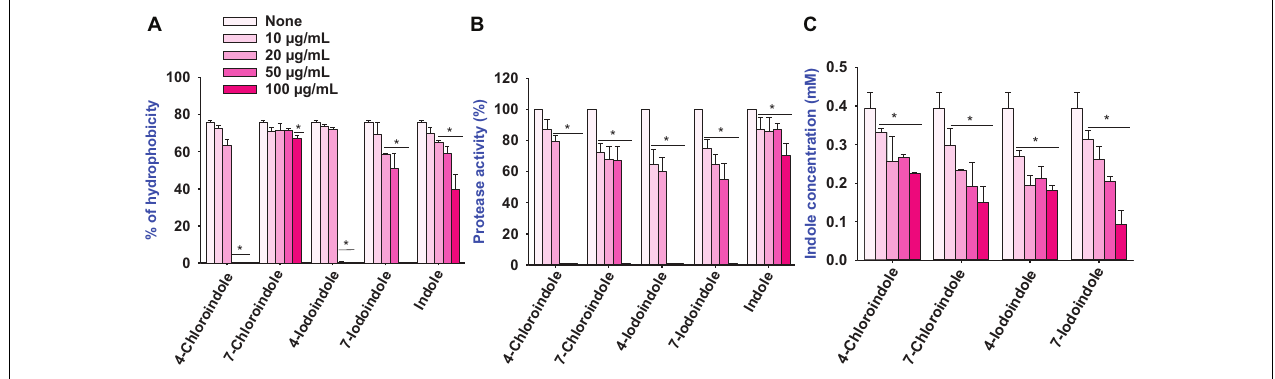
FIGURE 3 | Effect of halogenated indoles on the virulence factors of hydrophobicity (A) , protease activity (B) , and indole concentration (C) of V. parahaemolyticus. The error bars and asterisks (*) represent standard deviations and significant differences ( p < 0.05), respectively, vs. the non-treated controls.